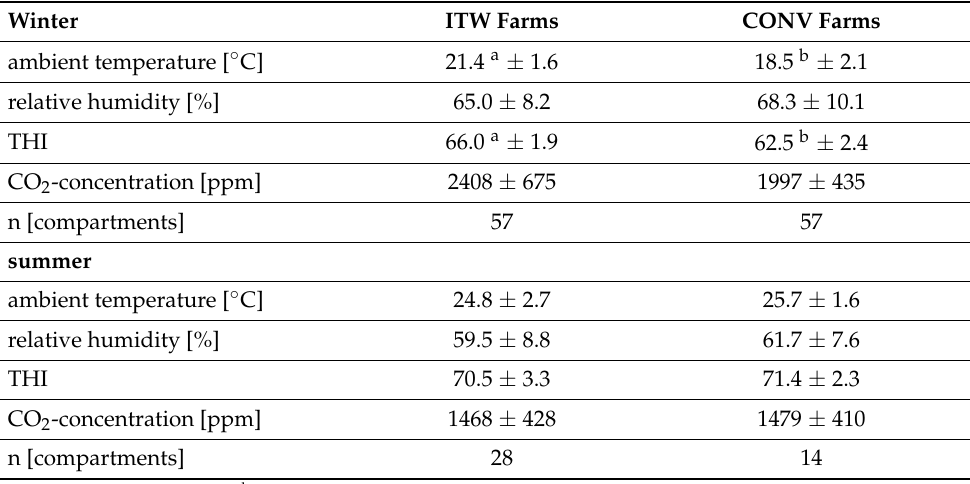
Table A1. Compartment climate in the winter (16 October–15 April) and in the summer season (16 April–15 October). Data are presented as means ± standard deviation and statistically